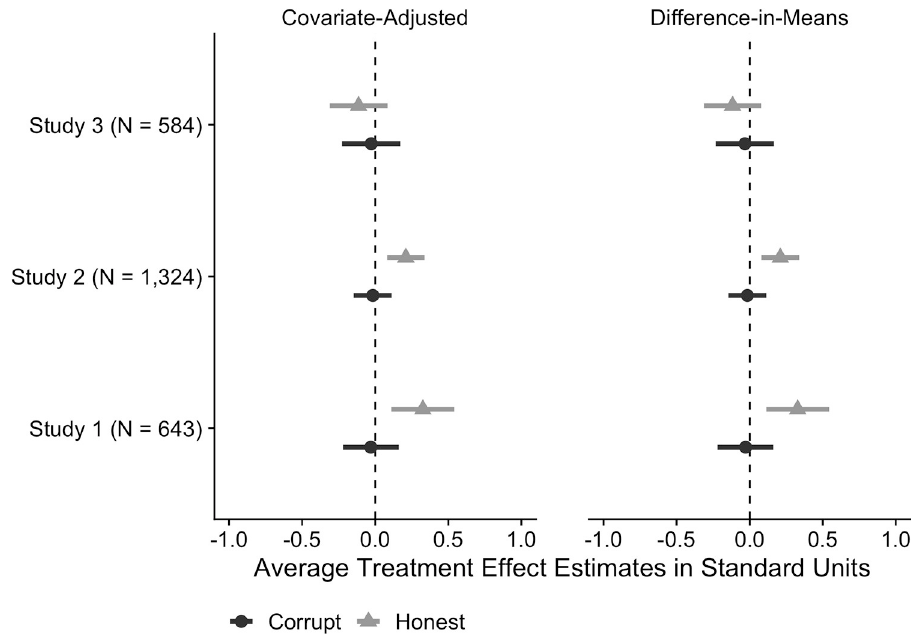
Fig 1. Estimated effects of Corrupt and Honest treatments on political trust (ANES Item) in Experiments 1–3.